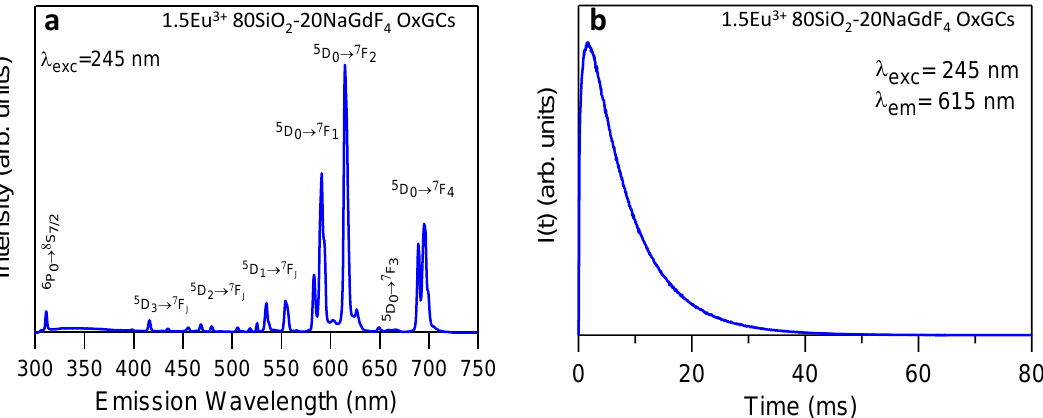
Figure 7. ( a ) Emission spectrum of Eu 3+ and Gd 3+ ions from OxGCs powders with the composition 80SiO 2 -20(1.5Eu 3+ : NaGdF 4 ) under excitation at 245 nm and ( b ) experimental decay curve from the 5 D 0 level obtained by collecting the luminescence at 615